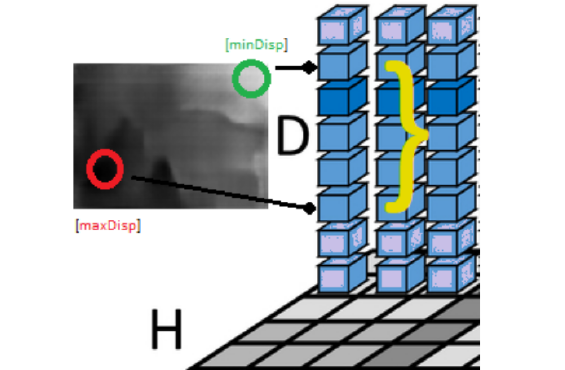
Figure 2. Disparity restriction from neural net estimation. Adapted from: (Hu et al.,